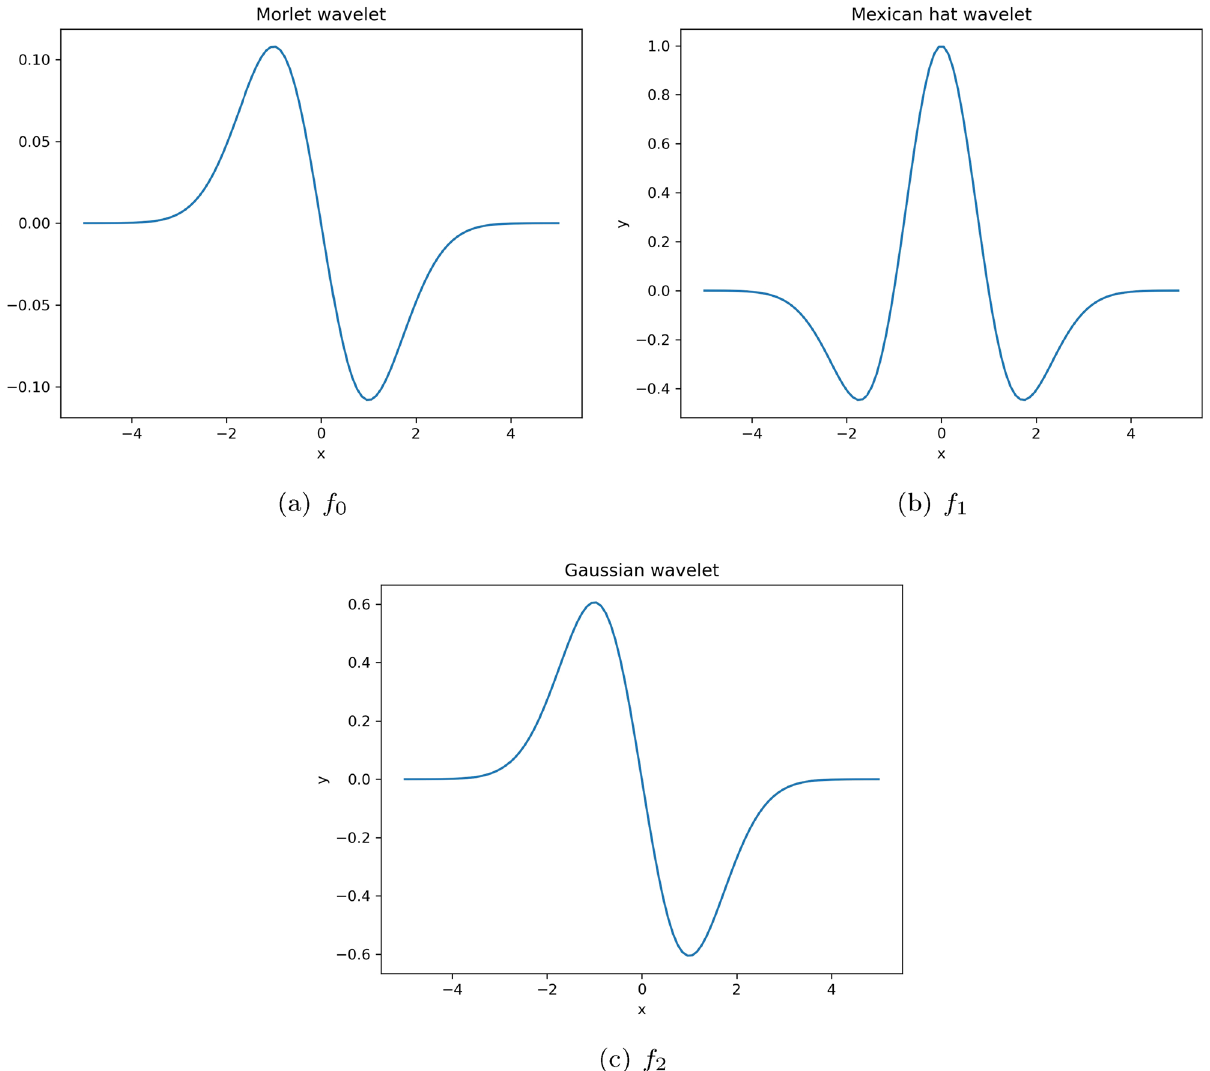
Figure 2. Diagrams of the used wavelet